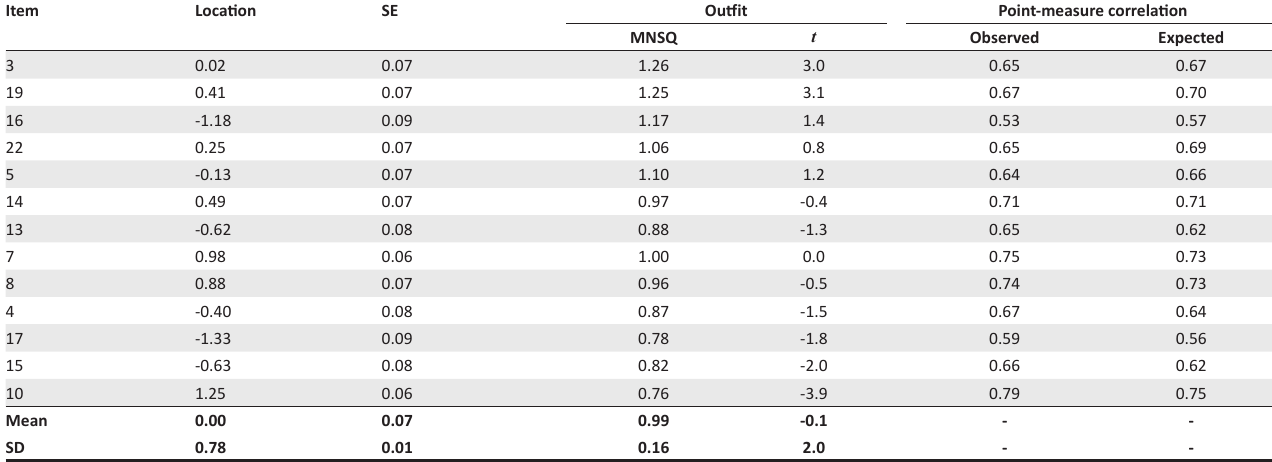
TABLE 2: Rasch item calibrations and fit statistics for 13 items (sorted according to fit). Item